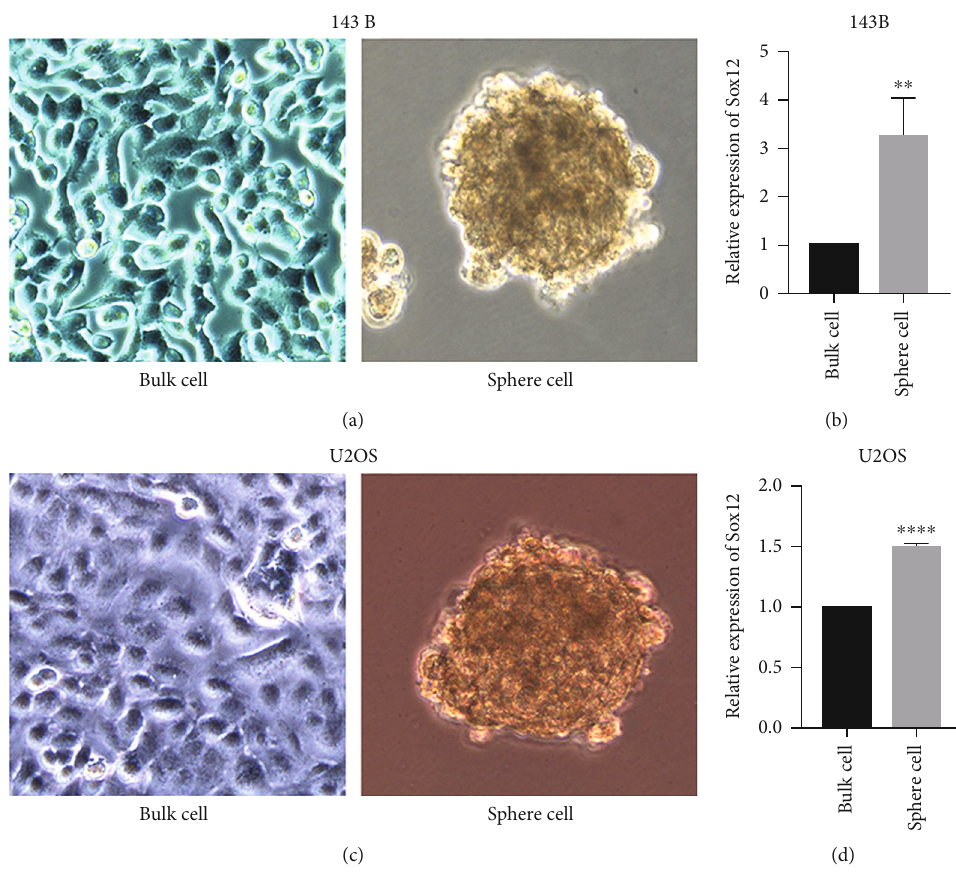
Figure 2: Osteosarcoma CSCs express high SOX12 levels. (a) Spheres formed under these culture conditions (osteosarcoma CSCs), as well as monolayer cells cultured under the regular culture conditions (143B bulk cells). (b) The relative mRNA expression of SOX12 in osteosarcoma CSCs and 143B bulk cells. (c) Spheres formed under these culture conditions (osteosarcoma CSCs), as well as monolayer cells cultured under the regular culture conditions (U2OS bulk cells). (d) The relative mRNA expression of SOX12 in osteosarcoma CSCs and U2OS bulk cells. ∗∗ p < 0 : 01 , ∗∗∗∗ p < 0 : 0001